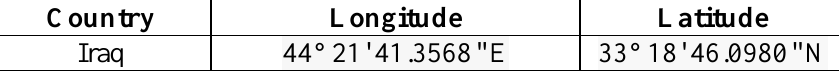
Table 2: The location of Iraq relative to longitude and latitude.